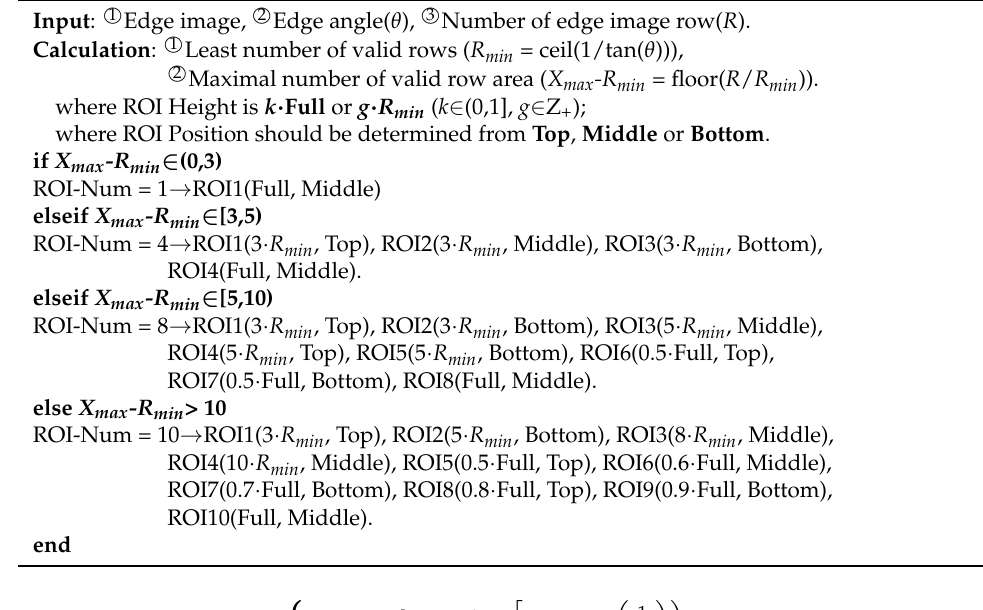
Algorithm 1 Automatic determination strategy of multi-ROI for edge